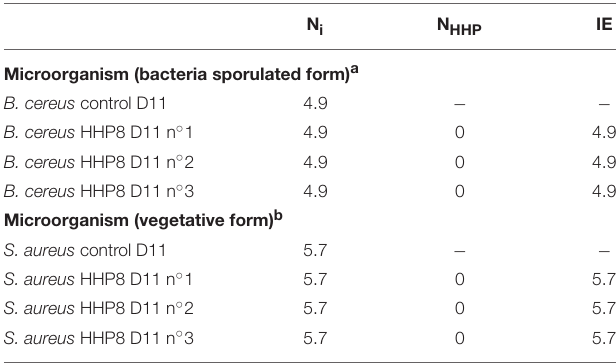
TABLE 1 | Inactivation Efficiency (IE) of B. cereus (ATCC 14579) (as spores) and Staphylococcus aureus (ATCC 6538) after the new High Hydrostatic Pressure (HHP)